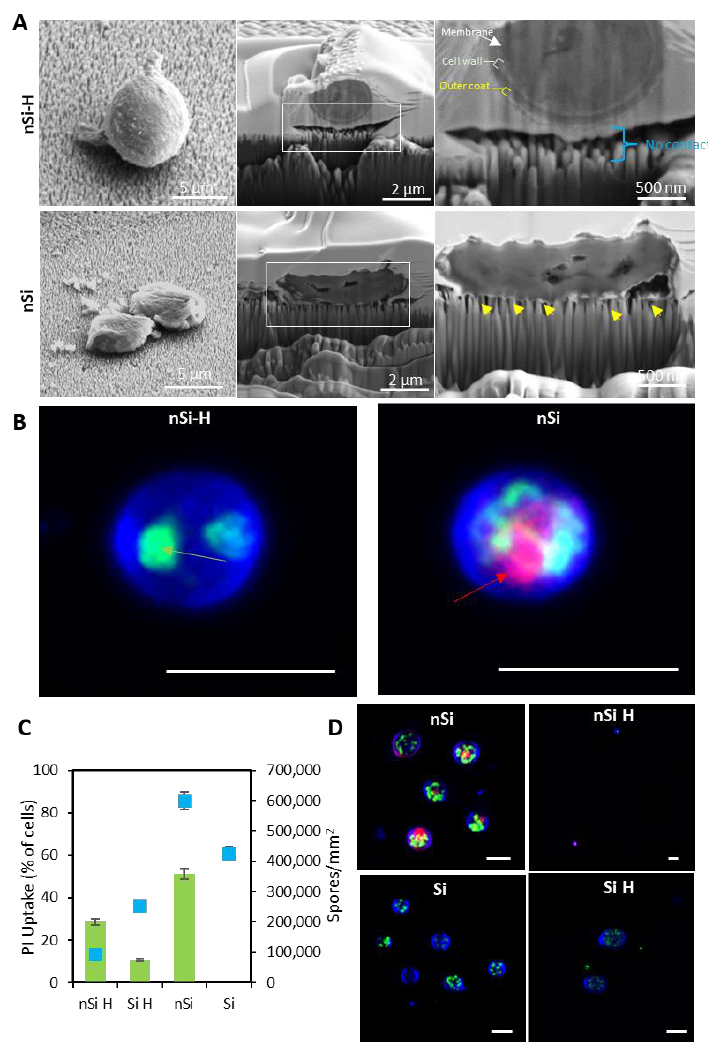
Figure 2. The interaction of A. brasiliensis spores with the nSi-H and nSi surfaces. ( A ) Representative FIB-SEM micrographs of A. brasiliensis spores present on the nSi-H and nSi substrates. The nanopillars of the hydrophilic nSi surface pierced the cell wall of the spores (yellow arrow), whereas the spores do not appear in direct contact with superhydrophobic surfaces (cyan bracket). Spore-surface interface is highlighted in white frames. ( B ) Representative high-resolution CLSM micrographs showing the cell membrane status of A. brasiliensis spores when attached onto nSi and Si surfaces, as determined by PI uptake. The conidia were stained with Calcofluor white (blue colour), which binds to cellulose and chitin in fungal cell walls; Syto9 (green colour), which is a membrane-permeable nucleic acid stain (green arrow); and propidium iodide (red colour), which also stains nucleic acids but is only membrane-permeable to damaged cells (red arrow). Scale bars are 5 µm. ( C ) Graph showing the percentage of spores that display internalised PI at day 1 incubation on studied surfaces (green colour) versus the number of spores observed per mm 2 (blue colour). Error bars are 1 standard deviation. ( D ) CLSM micrographs of PI uptake in A. brasiliensis spores. Scale bars are 5 µm.